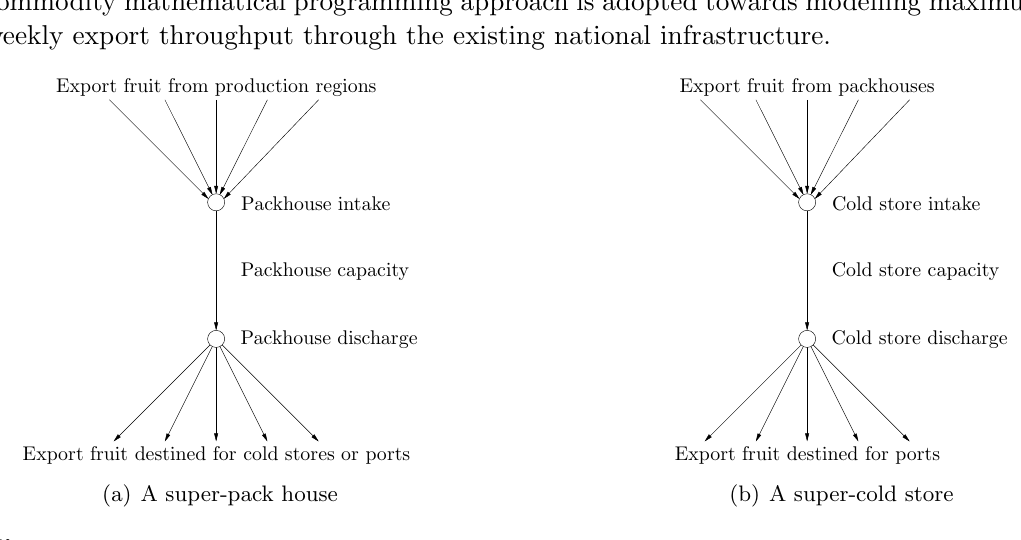
Figure 4: A section of the graph model illustrating the technique used to limit fruit flow to the capacities of super-pack houses and super-cold stores in the fruit export infrastructure. The same technique was used for port infrastructure such as cold stores and